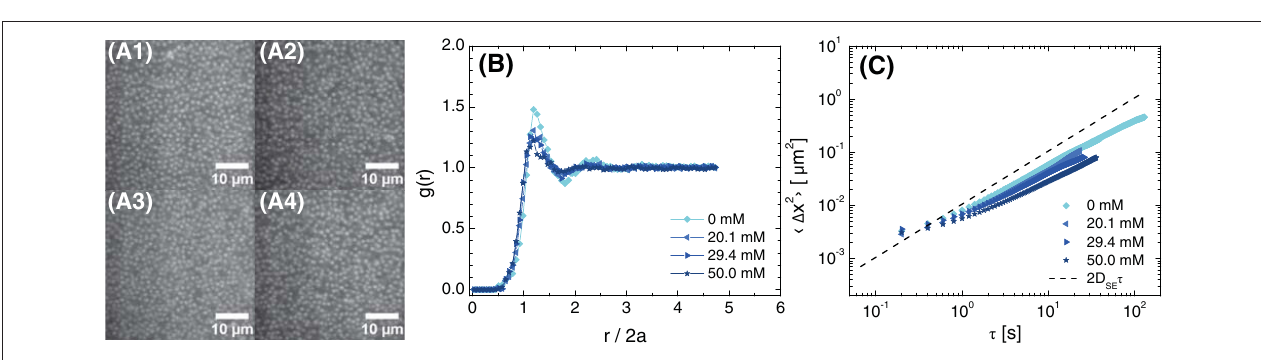
FIGURE 3 | (A) Confocal micrographs at z = 30 µ m (brightness/contrast adjusted), (B) radial distribution function as a function of normalized distance from the particle center, and (C) 1-dimensional mean-squared displacement as a function of delay time for φ = 0.05 suspensions in 80 (w/w)% glycerol in water with various concentrations of NaCl. The NaCl concentrations are (A1) 0 mM, (A2) 21.1 mM, (A3) 34.9 mM, and (A4) 50.2 mM. The dashed line in (C) is the calculated MSD for Stokes-Einstein diffusion in 80 (w/w)% glycerol in water with 20 mM NaCl.